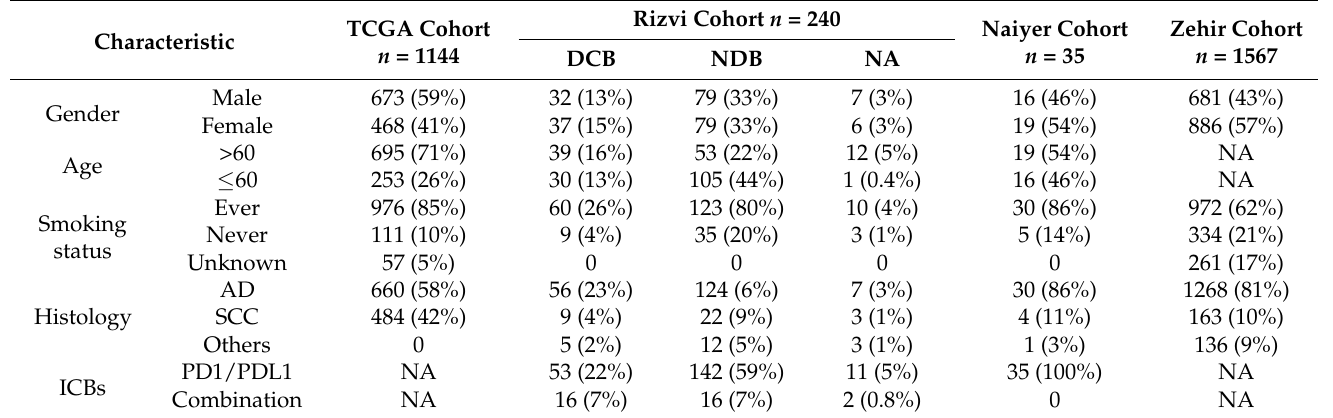
Table 1. Clinical characteristics of the included